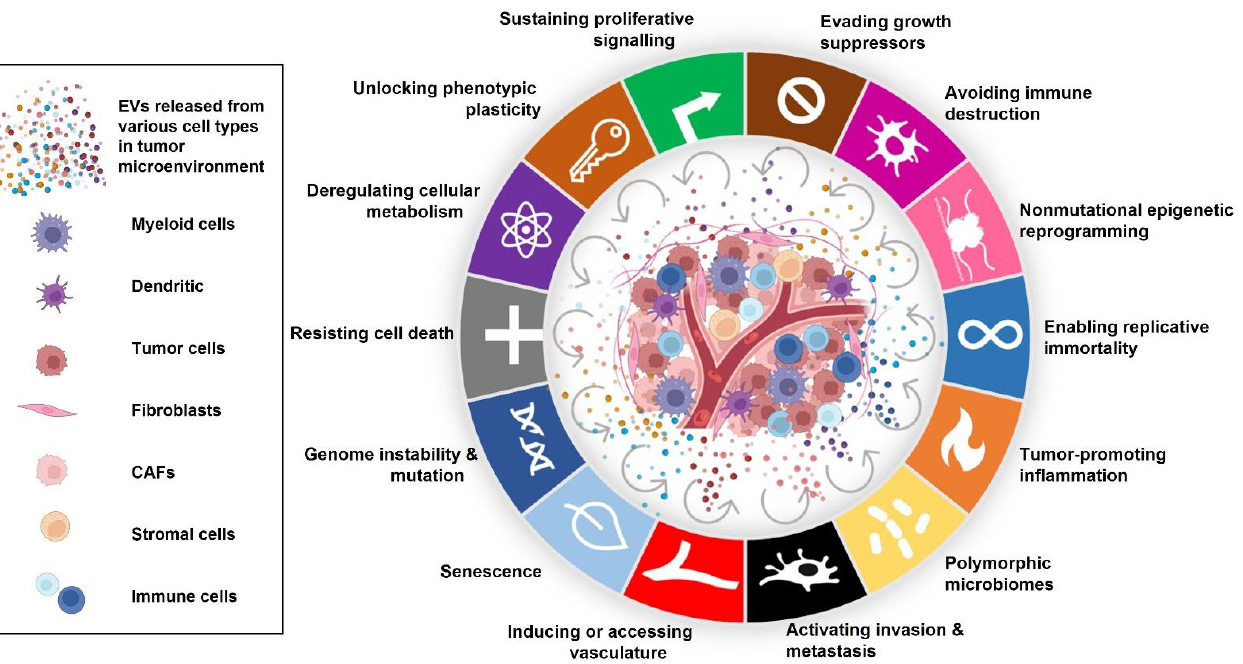
Figure 1. Role of EVs in the hallmarks of cancer. EVs secreted from various cell types in the tumour microenvironment can modulate the hallmarks of cancer which then leads to cancer progression and a poor prognosis.